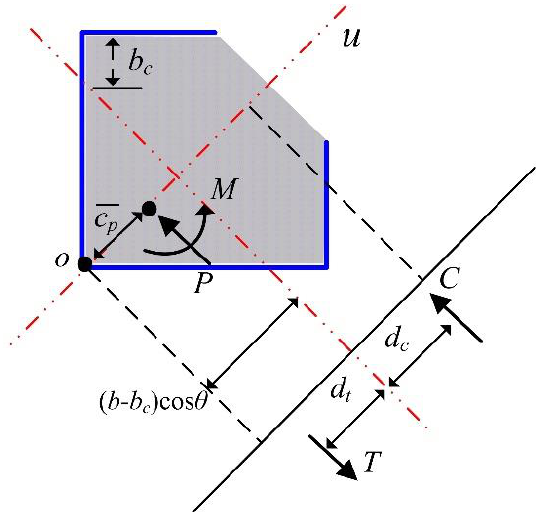
Figure 17. Relationship between P and M for arbitrary value of b c .